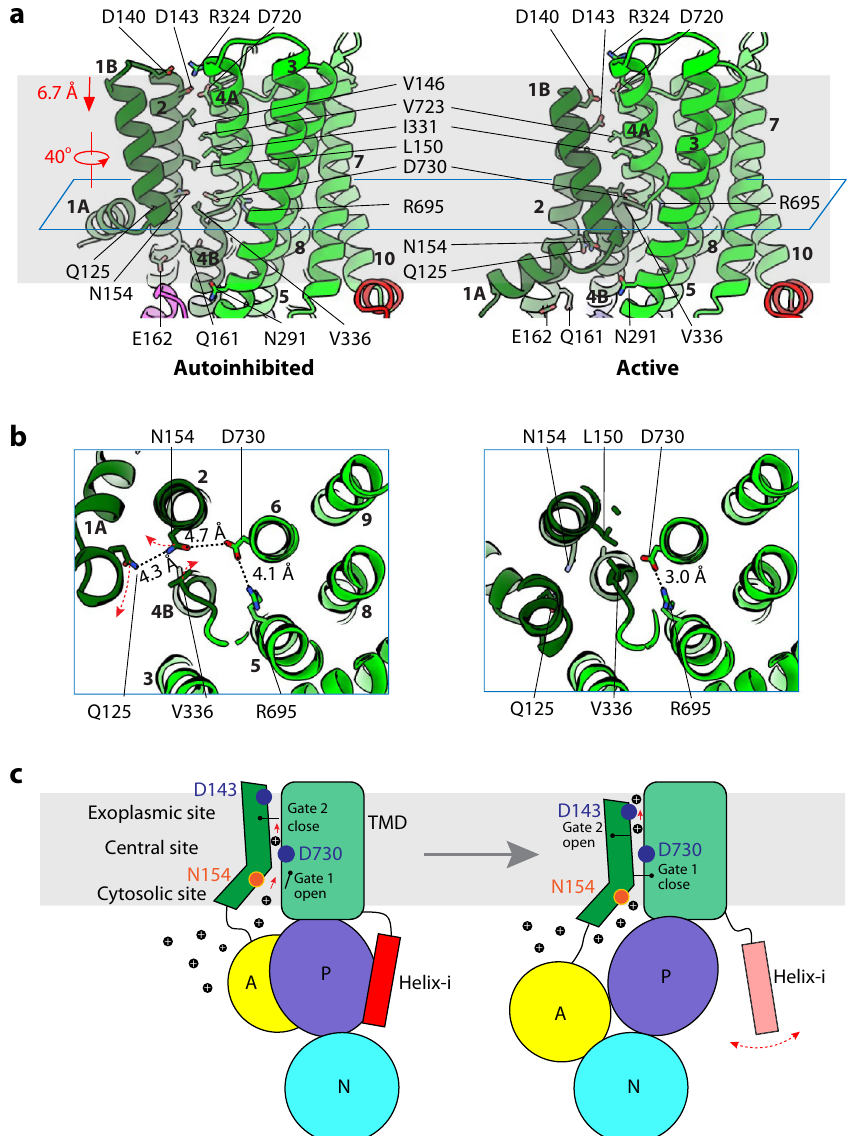
Fig. 5 Substrate transport mechanism of Pma1. a Putative substrate transport path of Pma1 in the autoinhibited (left) and active state (right). TMH1 – 2 move downward by 6.7 Å and rotate by 40°. Residues lining the path are shown as sticks. b Cut-in view from the exoplasmic side of the central proton binding site around D730 in the autoinhibited (left) and active state (right). The section plane is the cyan plane in ( a ). c A model for proton transport across the plasma membrane by Pma1. More details are in the